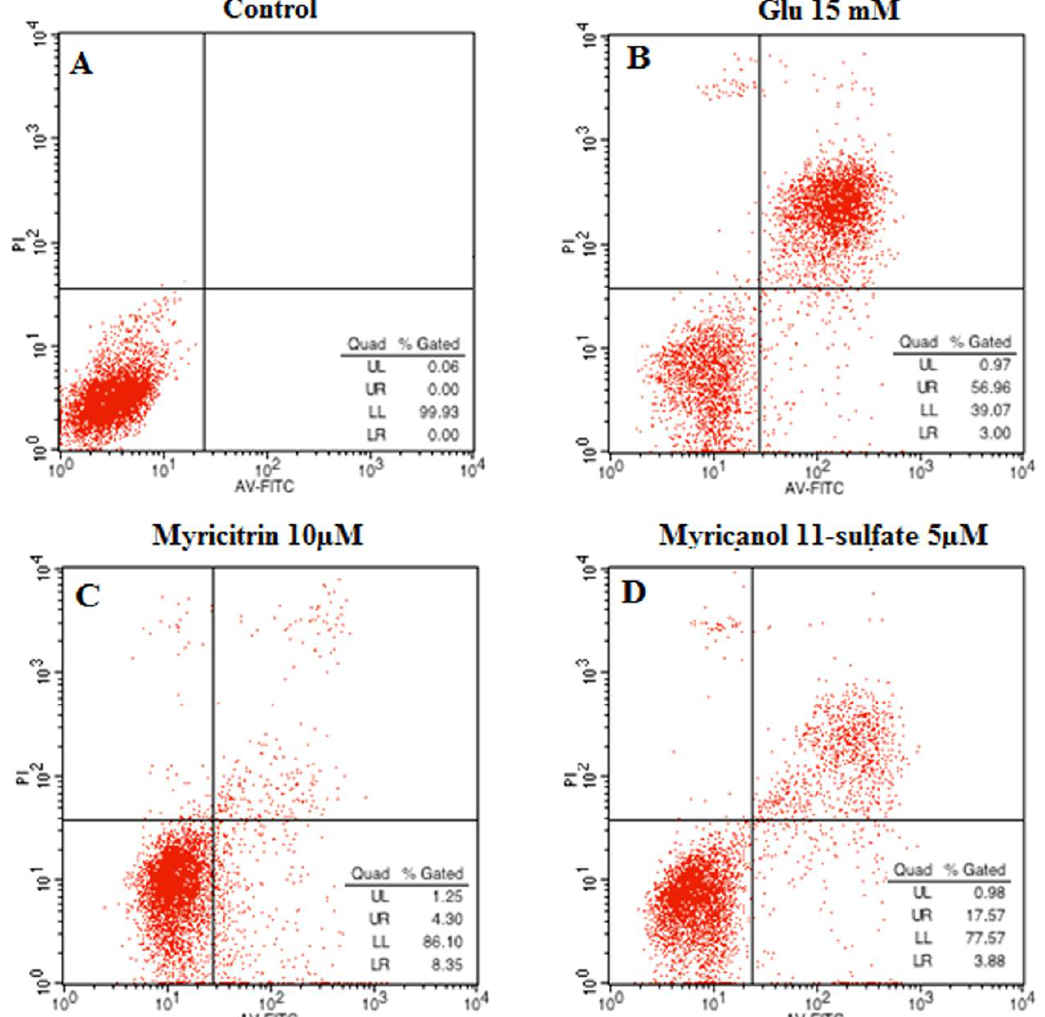
Figure 11. Effect of myricitrin and myricanol 11-sulfate on glutamate-induced apoptosis of PC12 cells analyzed by flow cytometer ( A ) control; ( B ) Cells with 15 mM glutamate treatment; ( C ) Cells treated with 10 µ M myricitrin after glutamate-induced PC12 cell damage; ( D ) Cells treated with 5 µ M myricanol 11-sulfate after glutamate-induced PC12 cell damage. Table 2. Effects of Myricetrin and myricanol 11-sulfate on intracellular ROS, Malondialdehyde (MDA)